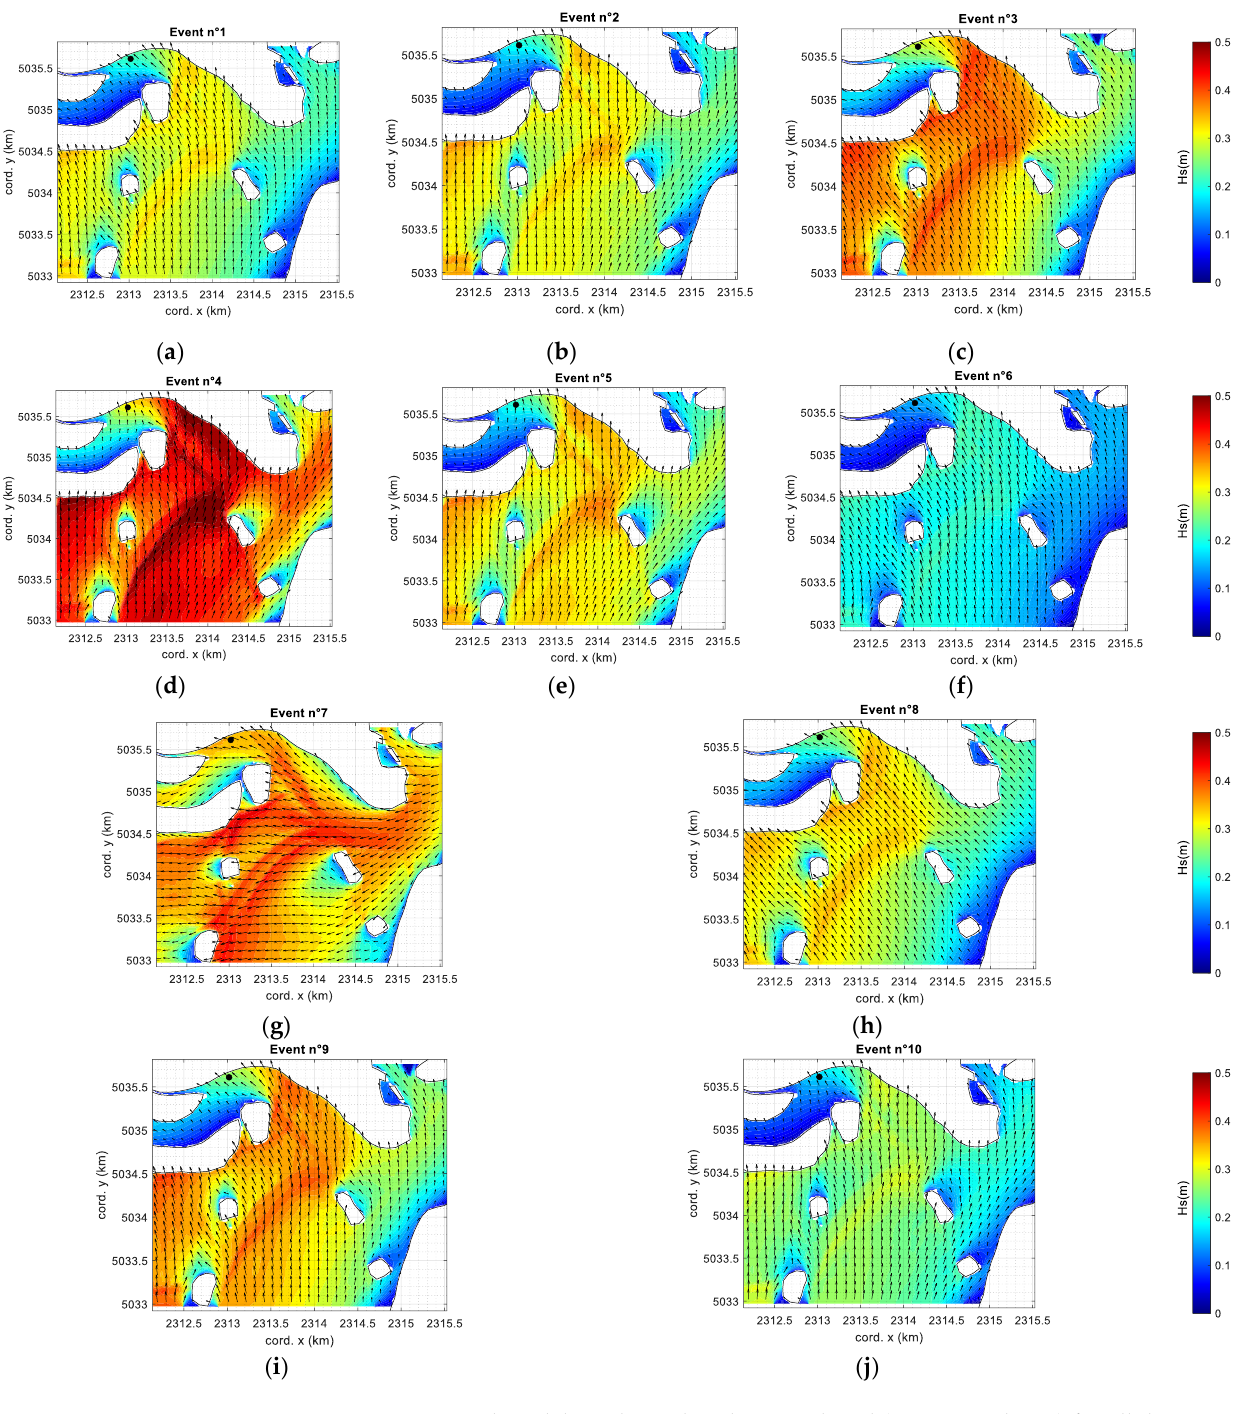
Figure 6. Numerical model results within the nested grid (San Marco basin) for all the 10 events listed in Table 1 (no. 1, 3, 4, 5, 9, 10 Mo.S.E. closures and no. 2, 6, 7, 8 ordinary events). The black dot indicates the position of the pressure gauges.